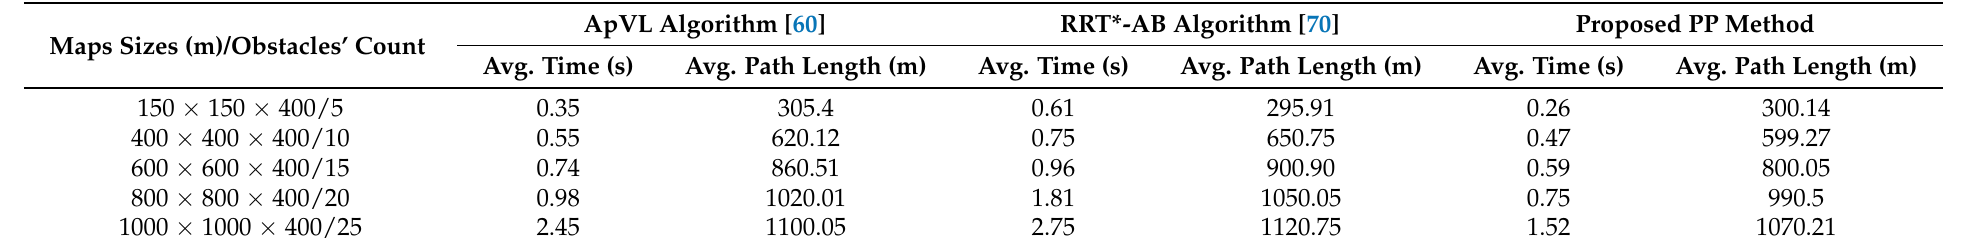
Table 2. Proposed method pathfinding results’ comparison with the ApVL and the RRT*-AB